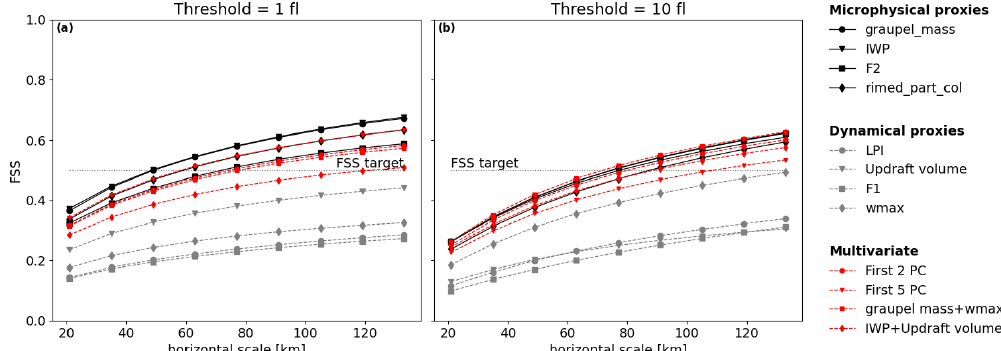
Figure 14. Same as Fig. 11 but the FSS for individual proxies are overlaid with the FSS for some multivariate models in